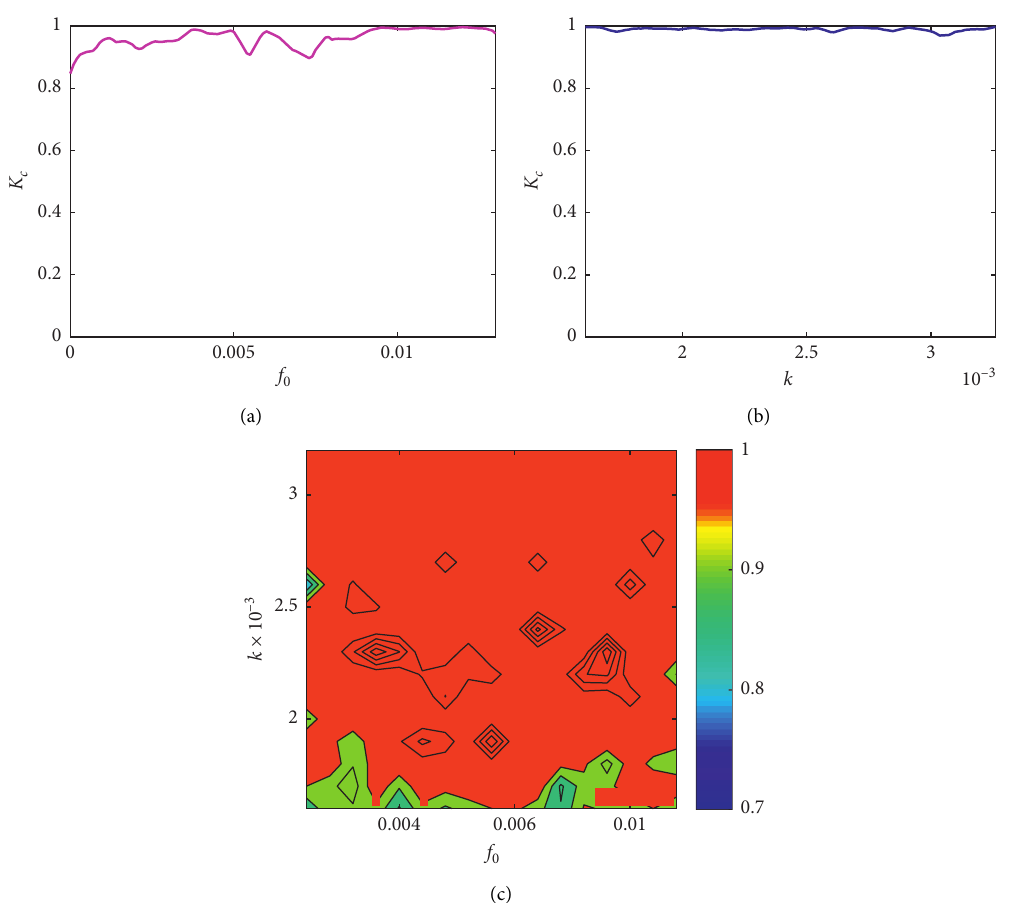
Figure 5: (a) represents K k ∈ [ 0 . 00161 , 0 . 00327 ] and f color bar indicates values of K c over the region [ 0 . 00161 , 0 . 00327 ] × [ 0 , 0 . 013 ] . In order to calculate K c , we have taken n ≪ n